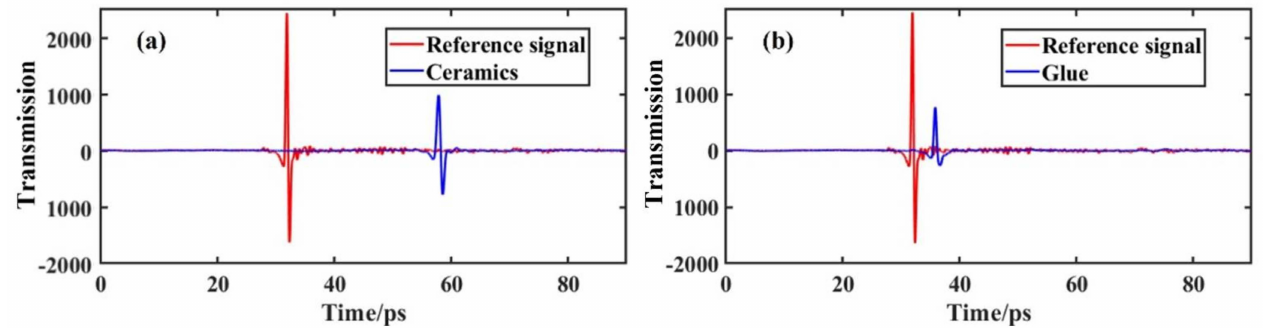
Figure 4. The transmission of ( a ) the ceramics and ( b ) the glue. According to the Ref. [26], transmission-mode terahertz detection is used to extract the optical parameters of the material. Figure 5 shows the real part of the refractive index for ceramics and glue. It can be found that the refractive index of the adhesive layer basically does not change with the frequency of the whole frequency segment, which can be regarded as a constant value. Therefore, the average refractive index of each frequency point is taken, and the average refractive index value is